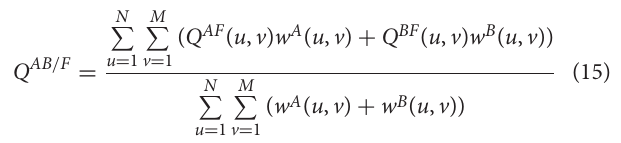
TABLE 1 | The key parameters used in our algorithms. LatLRR decomposition Threshold